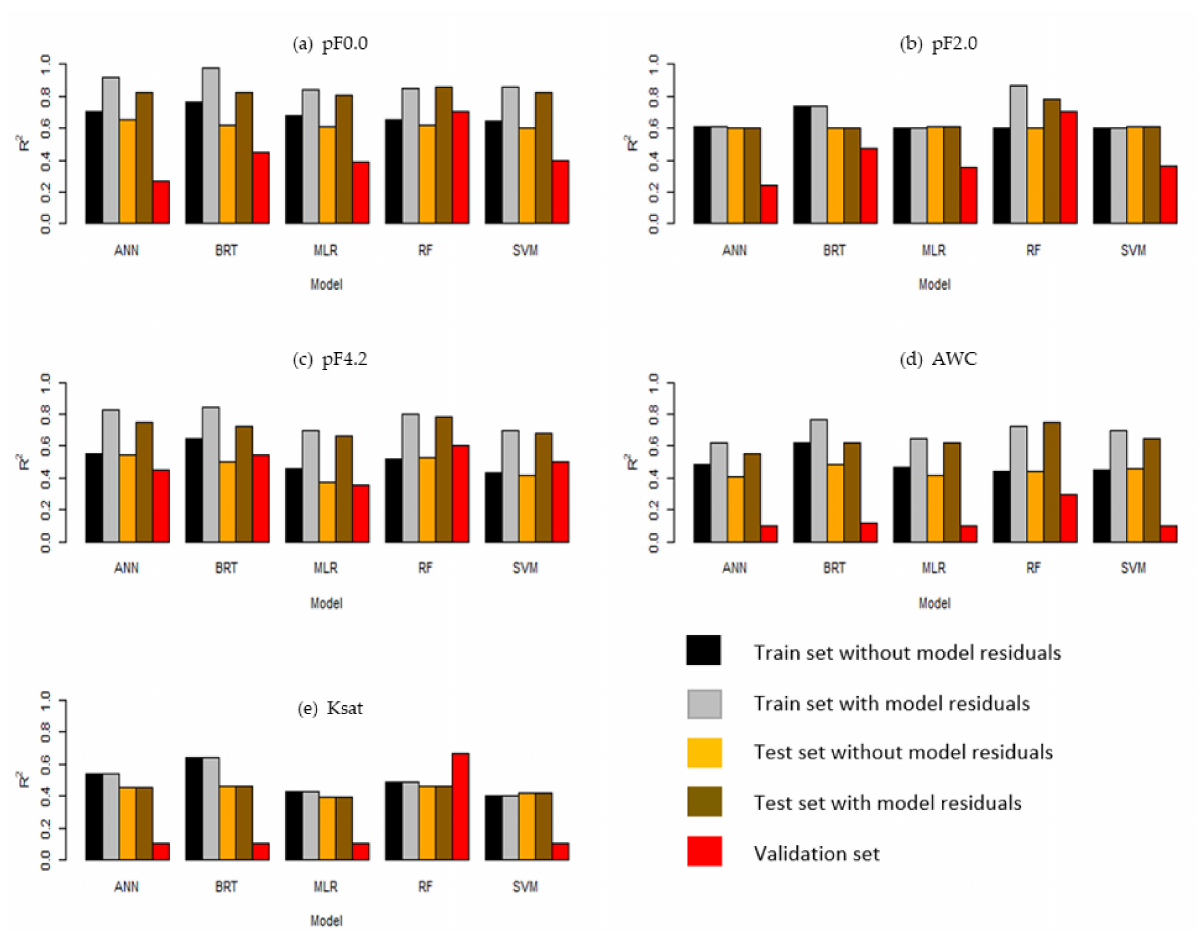
Figure 6. Coefficients of determination (R 2 ) for the five DSM models applied to the training sets without residuals (black), training sets with residuals (grey), test sets without residuals (orange), test sets with residuals (brown), and the validation data sets (red). ANN, artificial neural network; BRT, gradient boosted regression trees; MLR, multiple linear regression; RF, random forest; SVM, support vector machine. Panel ( a ) shows the response variable pF0.0, panel ( b ) for pF2.0, panel ( c ) for pF4.2, panel ( d ) for AWC and panel ( e ) for Ksat at a depth of 30